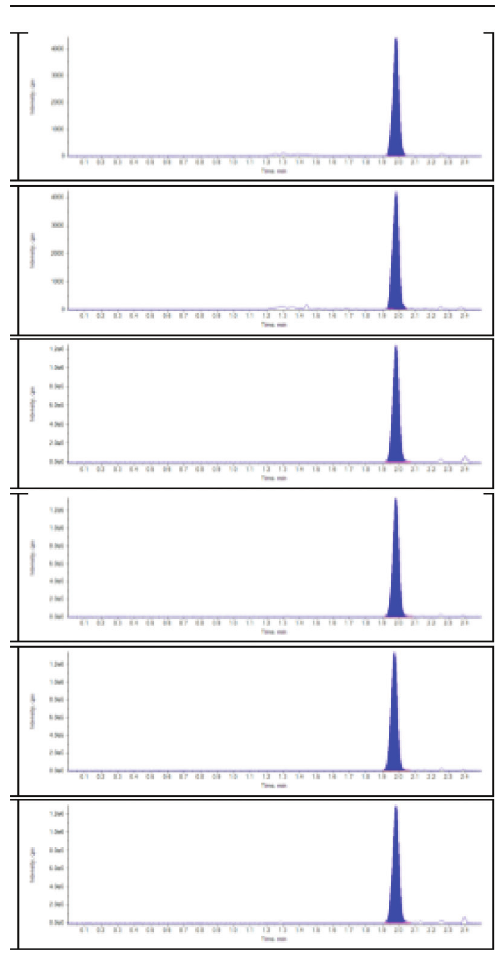
Figure 1. Typical multiple reaction monitoring chromatograms of atorvastatin.